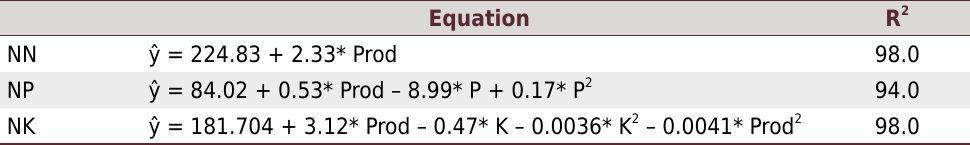
Table 1. Equations used in the recommendation for nitrogen, phosphorus and potassium rates